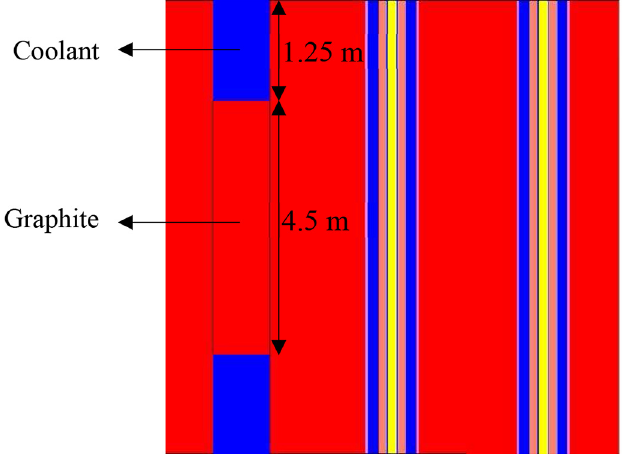
Fig. 7. Control rods are raised to the upper limit without poisoning.